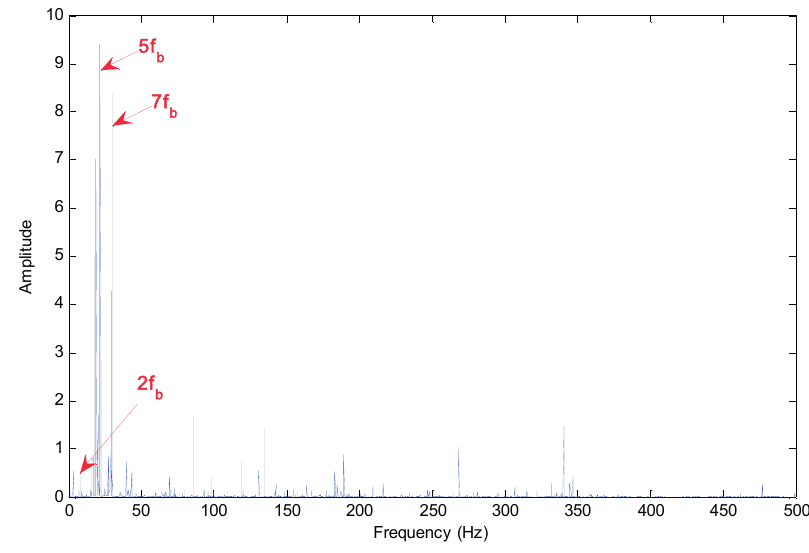
Figure 12. Hilbert marginal spectrum of selected IMFs for axle bearing vibrations with cage